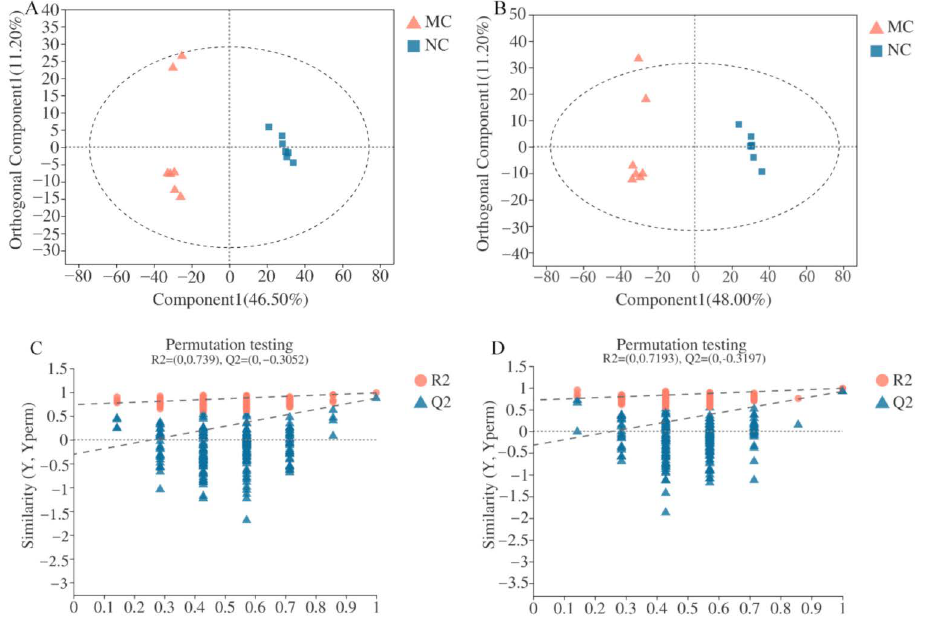
Figure 6. ( A , B ): Orthogonal partial least squares discrimination analysis (OPLS-DA) score plots of serum metabolic profiling in normal control (NC) vs. model control (MC) groups under positive-ion ( A ) and negative-ion ( B ) modes ( n = 7 mice / group). ( C , D ): Permutation test in positive- ( C ) and negative ( D )-ion modes of the NC vs. MC groups. The abscissa represents the replacement retention of the replacement test. The ordinate indicates the value of R2 (red dots) and Q2 (blue triangle) in the substitution tests. The two dashed lines represent the regression lines of R2 and